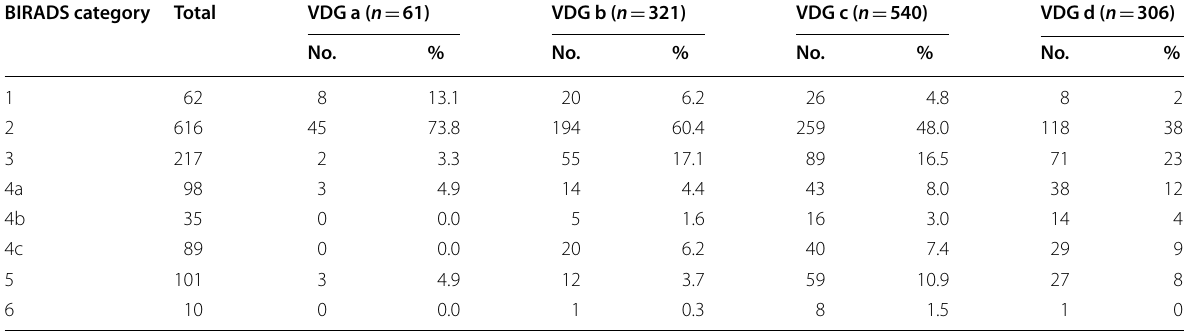
Table 4 Distribution of different BIRADS category among VDG BIRADS category